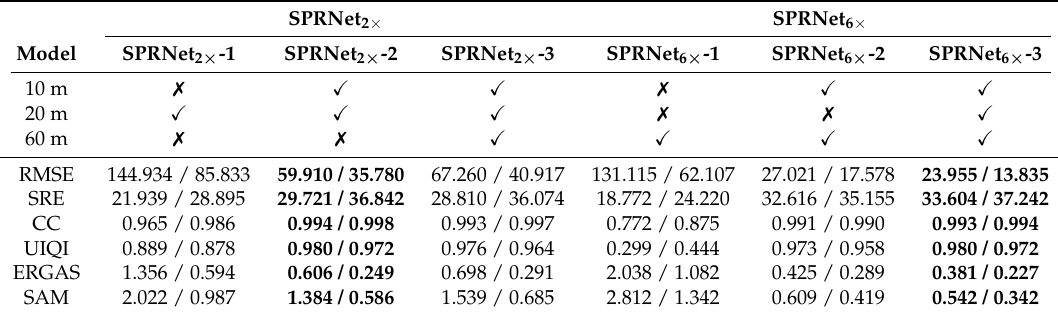
Table 6. The comparison results of the SPRNet with different combination of 10 m, 20 m and 60 m band sets.